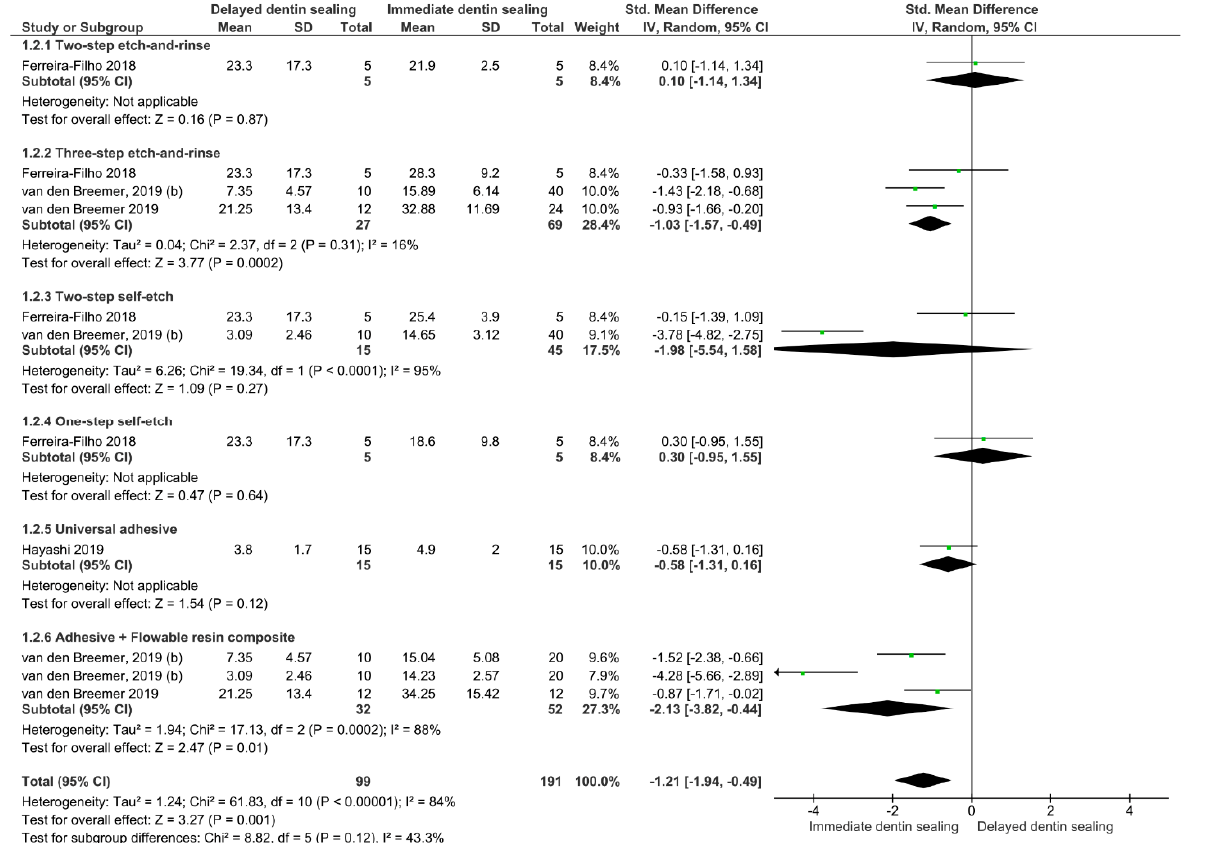
Figure 3. Forest plot of the aged bond strength comparison between the delayed and immediate dentin sealing techniques according to the adhesive used. Table 2. Qualitative synthesis for in vitro